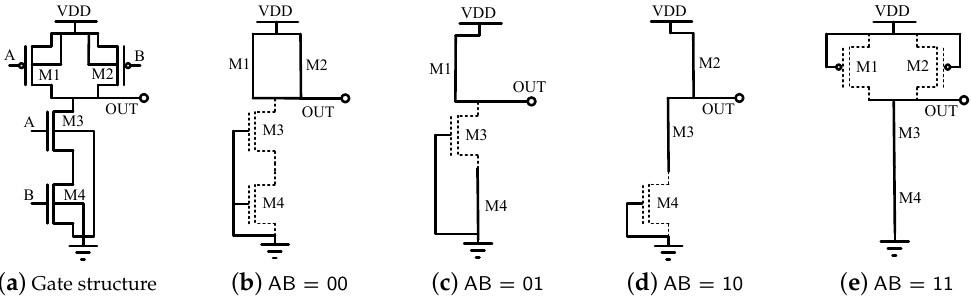
Figure 1. Classic NAND gate, and the status of the transistors for different input